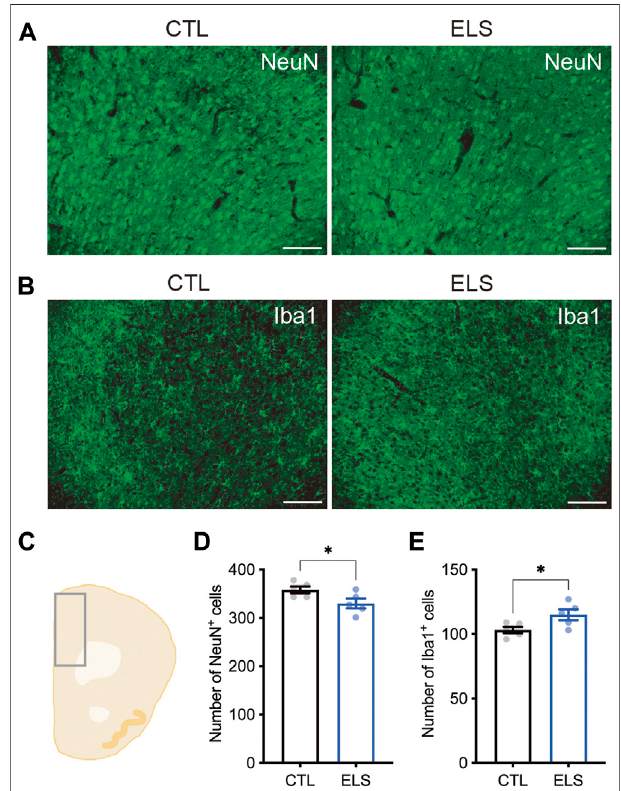
FIGURE 4 | Neuronal loss and microglia increase in the PFC of ELS mice. (A, B) Representative fl uorescent images of NeuN+ neuron (A) and Iba1+ microglia (B) . (C) Schematic diagram of mouse cortex analyzed at bregma 1.94. (D, E) Quanti fi cations of NeuN+ neuron (D) and Iba1+ microglia (E) in the PFC. Decreased NeuN+ neurons and increased Iba1+ microglia were observed in the PFC of adolescent ELS mice. Data are presented as means ( ± SEM). Asterisk indicates * p < 0.05, unpaired t -test, n (cid:2) 5/condition. Scale bars: 100 μ m.